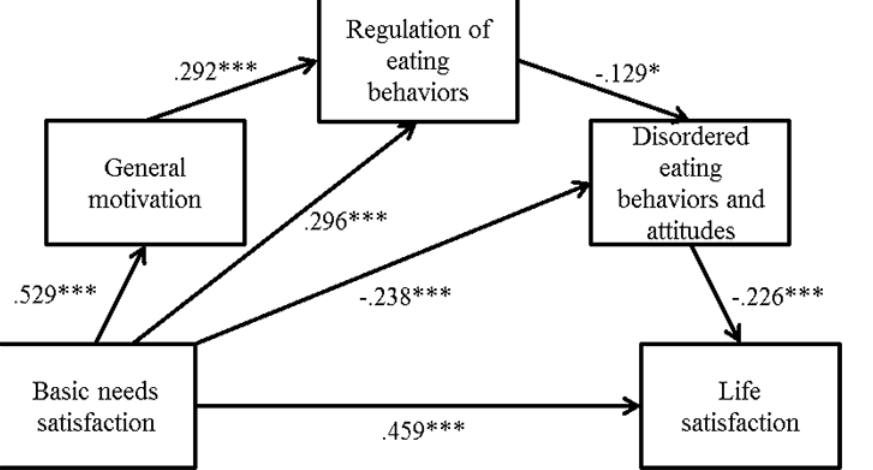
Figure 1. Serial multiple mediation analysis relating basic psychological needs satisfaction, general motivation, regulation of eating behaviors, disordered eating behaviors and attitudes, and life satisfaction. Note. N = 237. Values are standardized regression coefficient; only significant paths are reported. (The exact same model has been reproduced with only the disorder eating